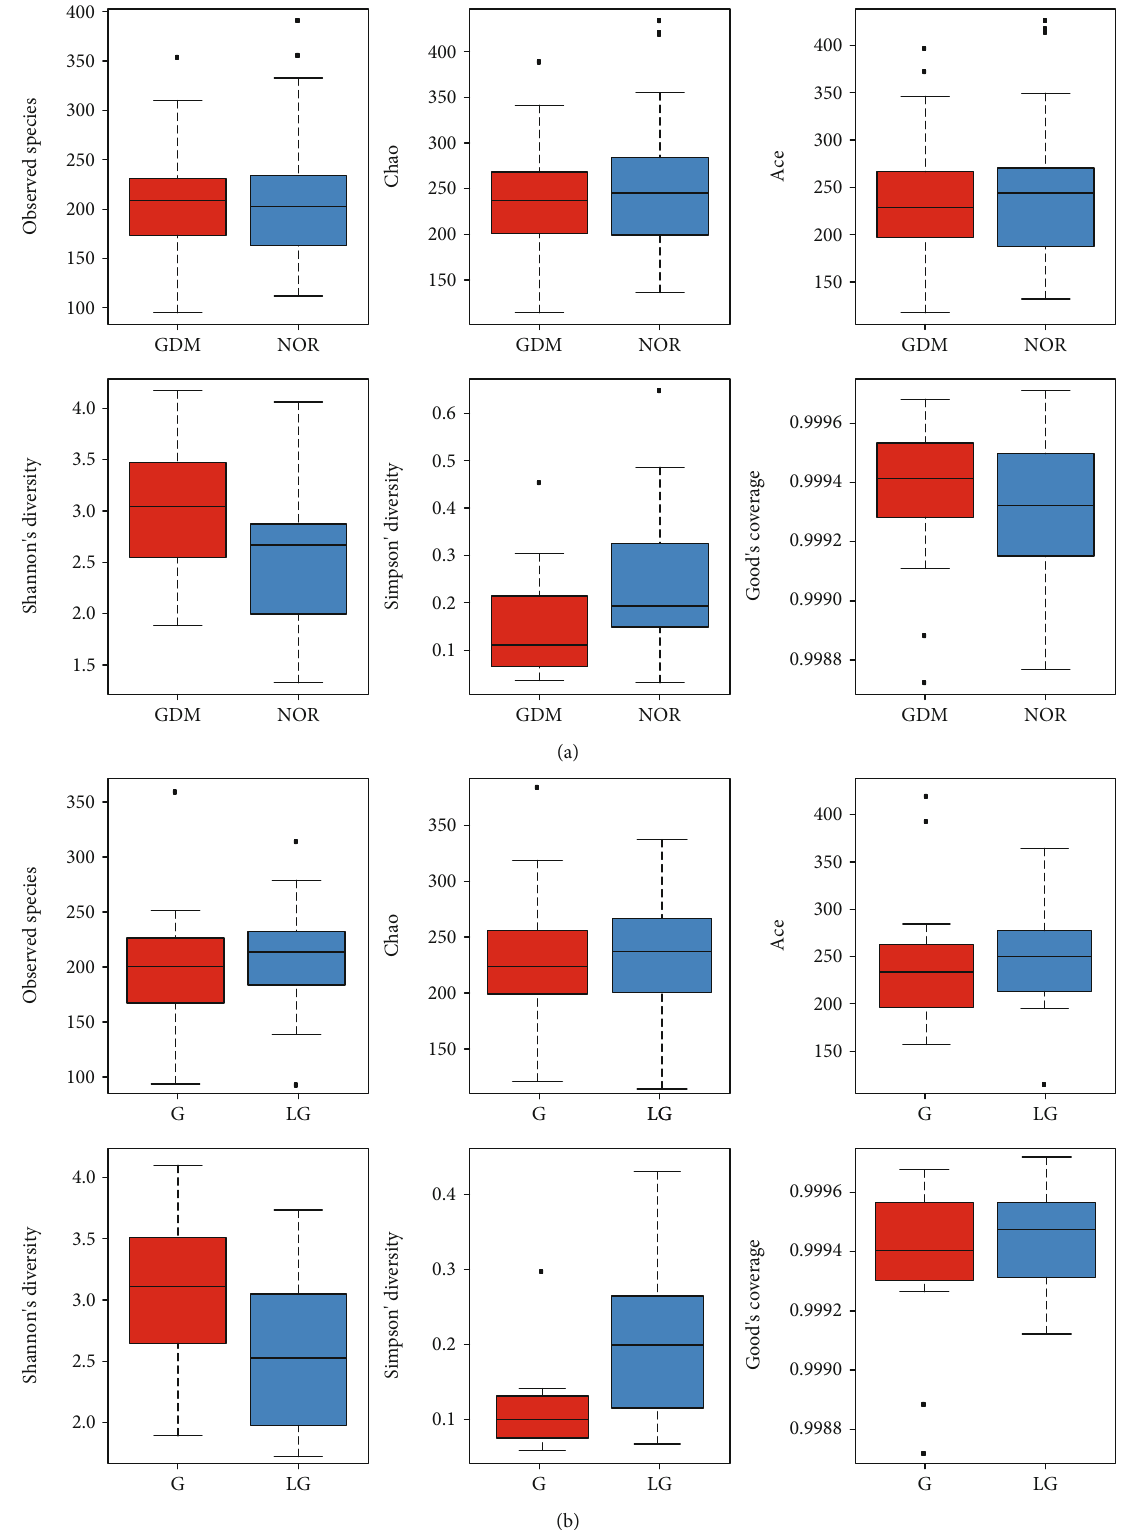
Figure 1: Analysis of OTU α diversity of intestinal fl ora in the NOR and GDM groups and the G and LG groups. (a) Comparison of the results of OTU α diversity analysis of intestinal microbes in the NOR and GDM groups. (b) Comparison of the results of OTU α diversity analysis of intestinal microbes in the G and LG